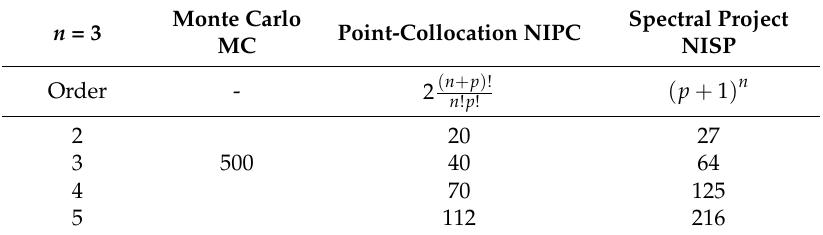
Table 3. The total numbers of selected points for Monte Carlo, NIPC, and NISP for three chosen points ( n is the dimension and p is the order of stochastic